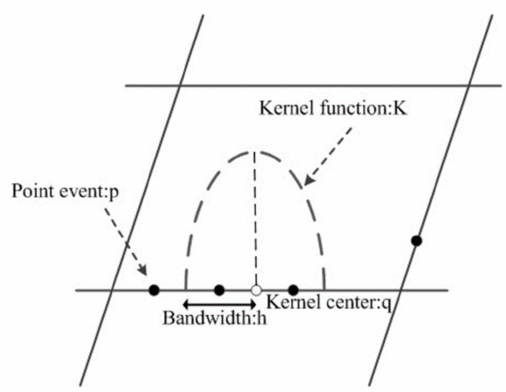
Figure 8. Network kernel density estimation schematic